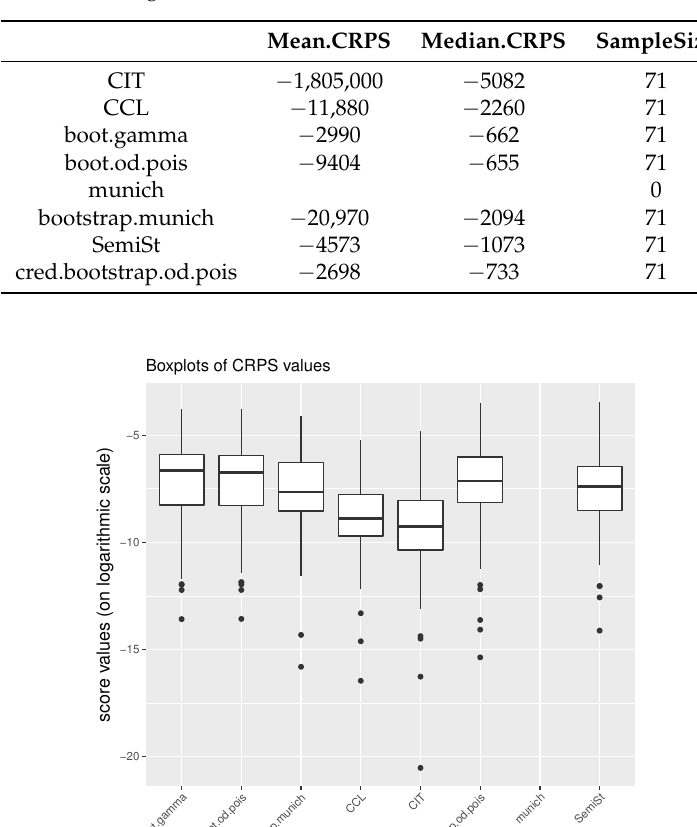
Figure 4. Boxplots of CRPS values from the commercial auto data. Table 10. Average and median CRPS values from the commercial auto data.